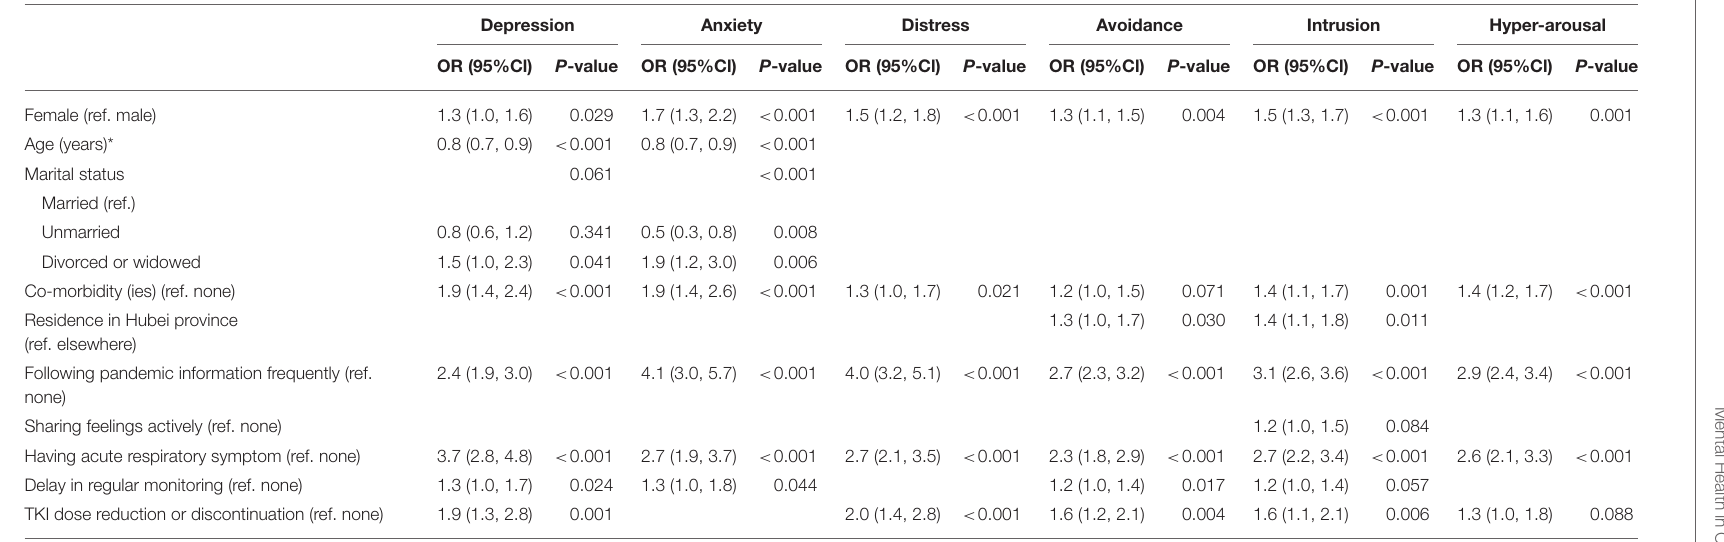
TABLE 4 | Multivariate analyses of mental health of respondents with CML. Depression Anxiety Distress Avoidance Intrusion